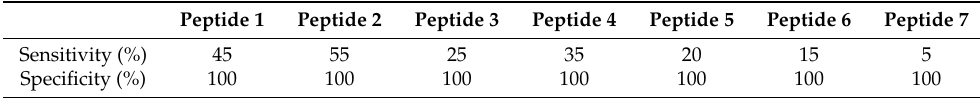
Table 3. Diagnostic sensitivity and specificity of the seven EAV peptides that were selected based on their performance on the peptide microarray (as determined by the cut-off ( p < 0.0000001)). Peptide 1 Peptide 2 Peptide 3 Peptide 4 Peptide 5 100 100 100